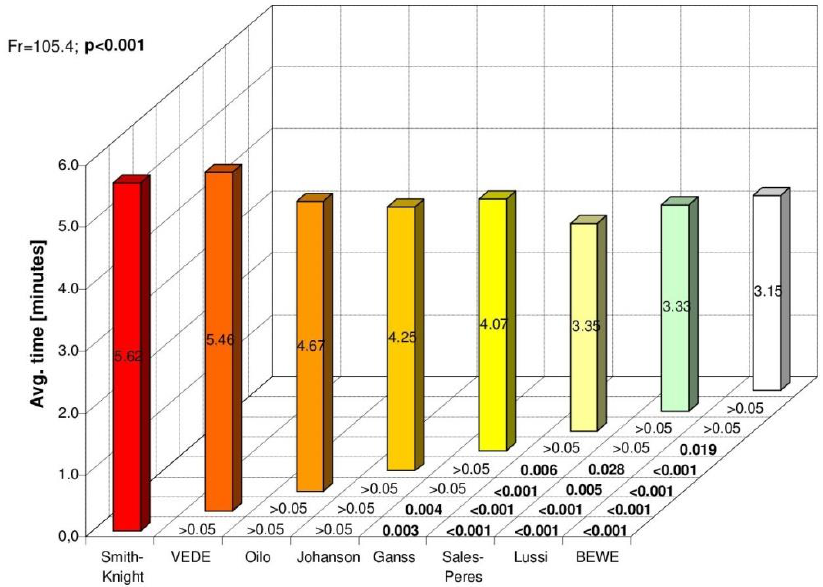
Figure 2. The result of the Friedman test in the assessment of the significance of the differences in the test time using individual wear/erosion indexes in the control group.